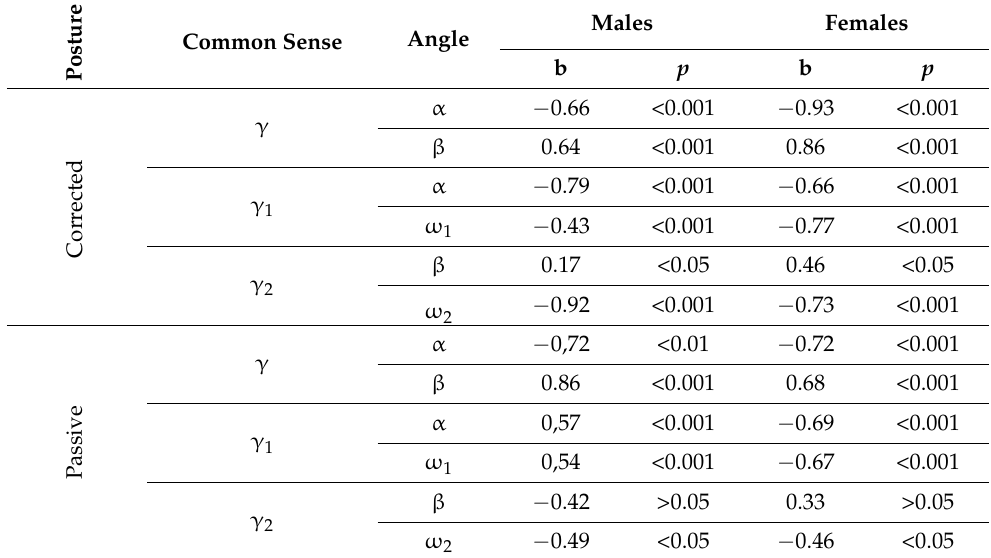
Table 5. Results of the regression analysis of individual “common senses” in relation to the analyzed